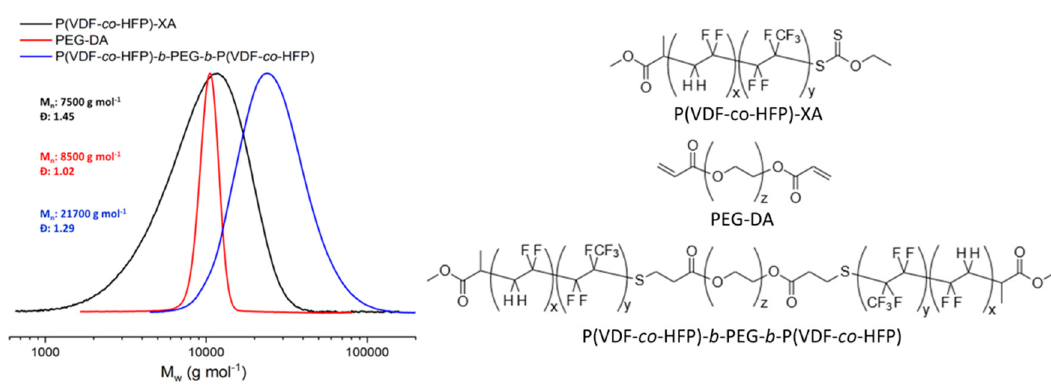
Figure 1. Normalized SEC chromatograms (viscometer detector) of P(VDF- co -HFP)-XA (black trace), PEGDA (red trace), P(VDF- co -HFP)- b -PEG- b -P(VDF- co -HFP) (blue trace), and chemical structure of the precursor polymers and final triblock